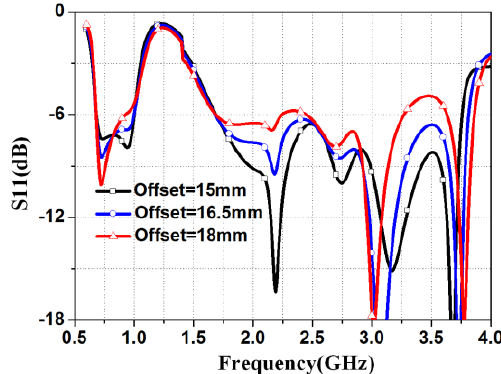
Figure 6. Simulated S-parameters with different lengths of Offset.